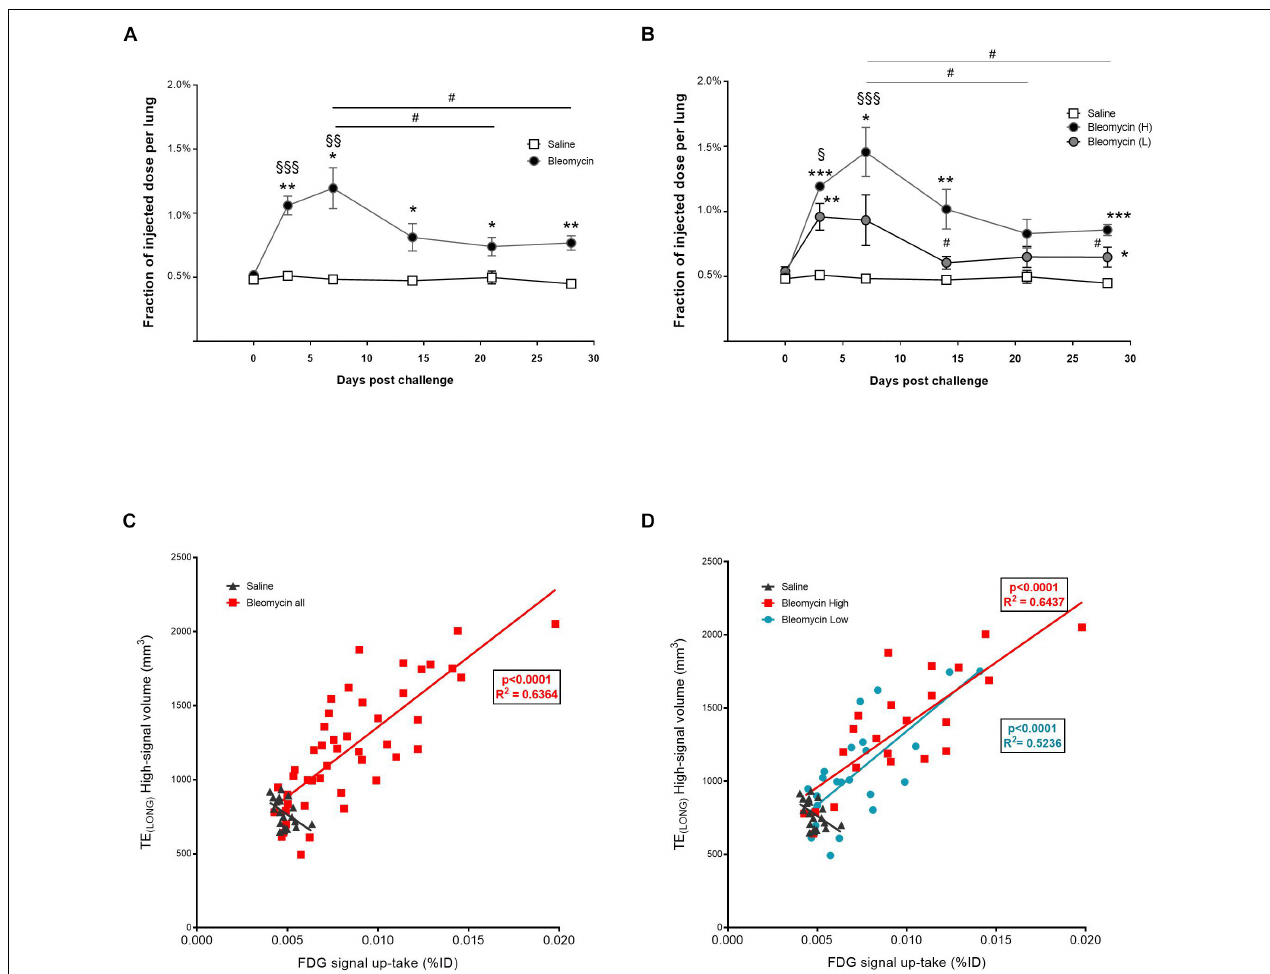
FIGURE 6 | Quantification of PET-FDG signal up-take during inflammation and fibrosis. (A) Up-take of FDG-PET at different scan days, showed peak levels at inflammation (day 7), although does not return back to baseline values (saline) even though inflammation is not present during the fibrotic phase. Here the amount of animals was n = 4 in the saline group and n = 8 in the bleomycin group. (B) The signal peak of FDG-PET remains at day 7, also when presented according to the separated groups of high- and low-responders. Here the amount of animals was n = 4 in the saline group and n = 4 in each bleomycin group. Significance is indicated by * when p < 0.05; p < 0.01 by ** and p < 0.001 by ***, when comparing bleomycin towards the saline control from the same time point. The comparison of various time points between bleomycin-challenged groups is expressed as # when p < 0.05, while bleomycin group compared towards baseline (within the same group of animals), significance is indicated by § when p < 0.01; p < 0.01 by §§ and p < 0.001 by §§§. (C) PET signal up-take correlate with MRI signal (TE LONG ), presented within the whole bleomycin-challenged group. The red line in the graph is a linear fit to data from all animals, the R 2 value is for this fit ( R 2 = 0.6364). (D) When presenting the separate groups of high- and low-responders, still significant correlation is observed. The red line in the graph is a linear fit to data from the high-responder group ( R 2 = 0.6437) while the blue line is linear fit to data from the low-responder group ( R 2 = 0.5236). For the statistical analysis, Spearman ’ s rank correlation was